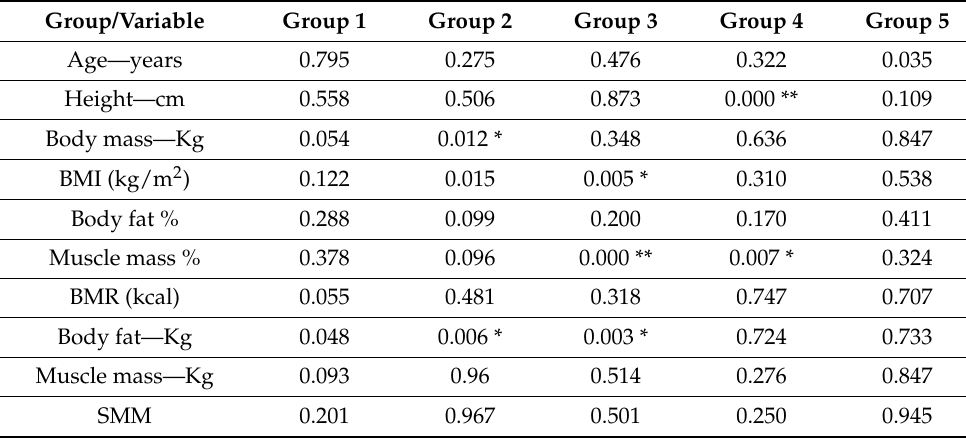
Table 2. The values of the distribution normality test